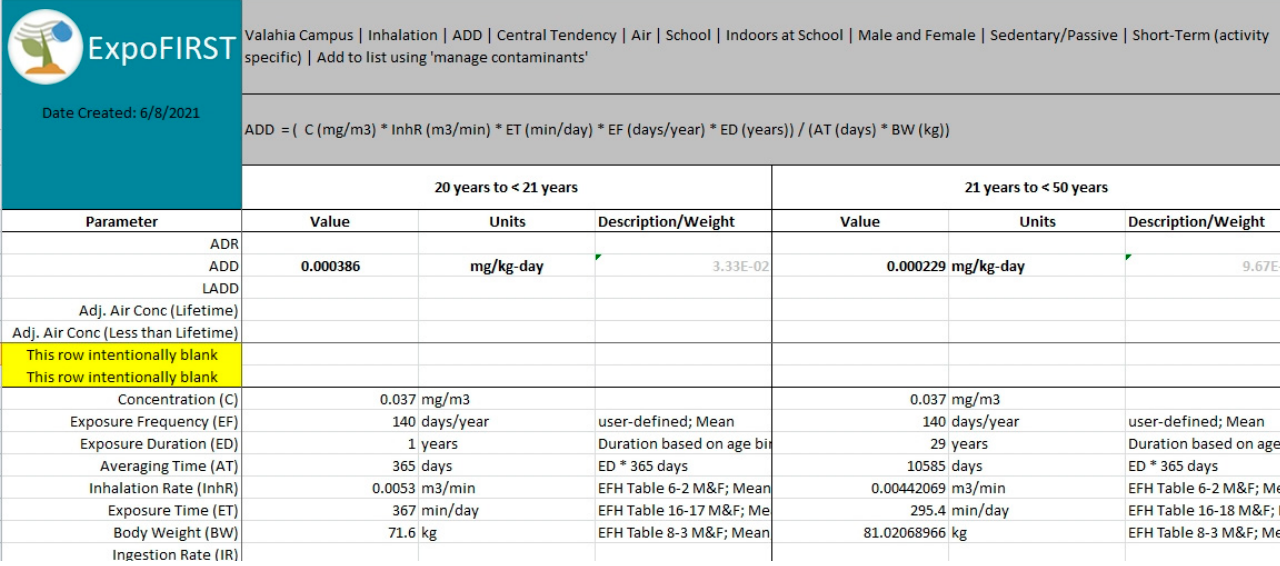
Figure A4. Screen capture of ExpoFIRST Version 2.0 application for inhalation dose calculation (EPA’s exposure factors interactive resource for scenarios tool https://cfpub.epa.gov/ncea/risk/recordisplay.cfm?deid=322489#tab-3, accessed on 5 June 2021).